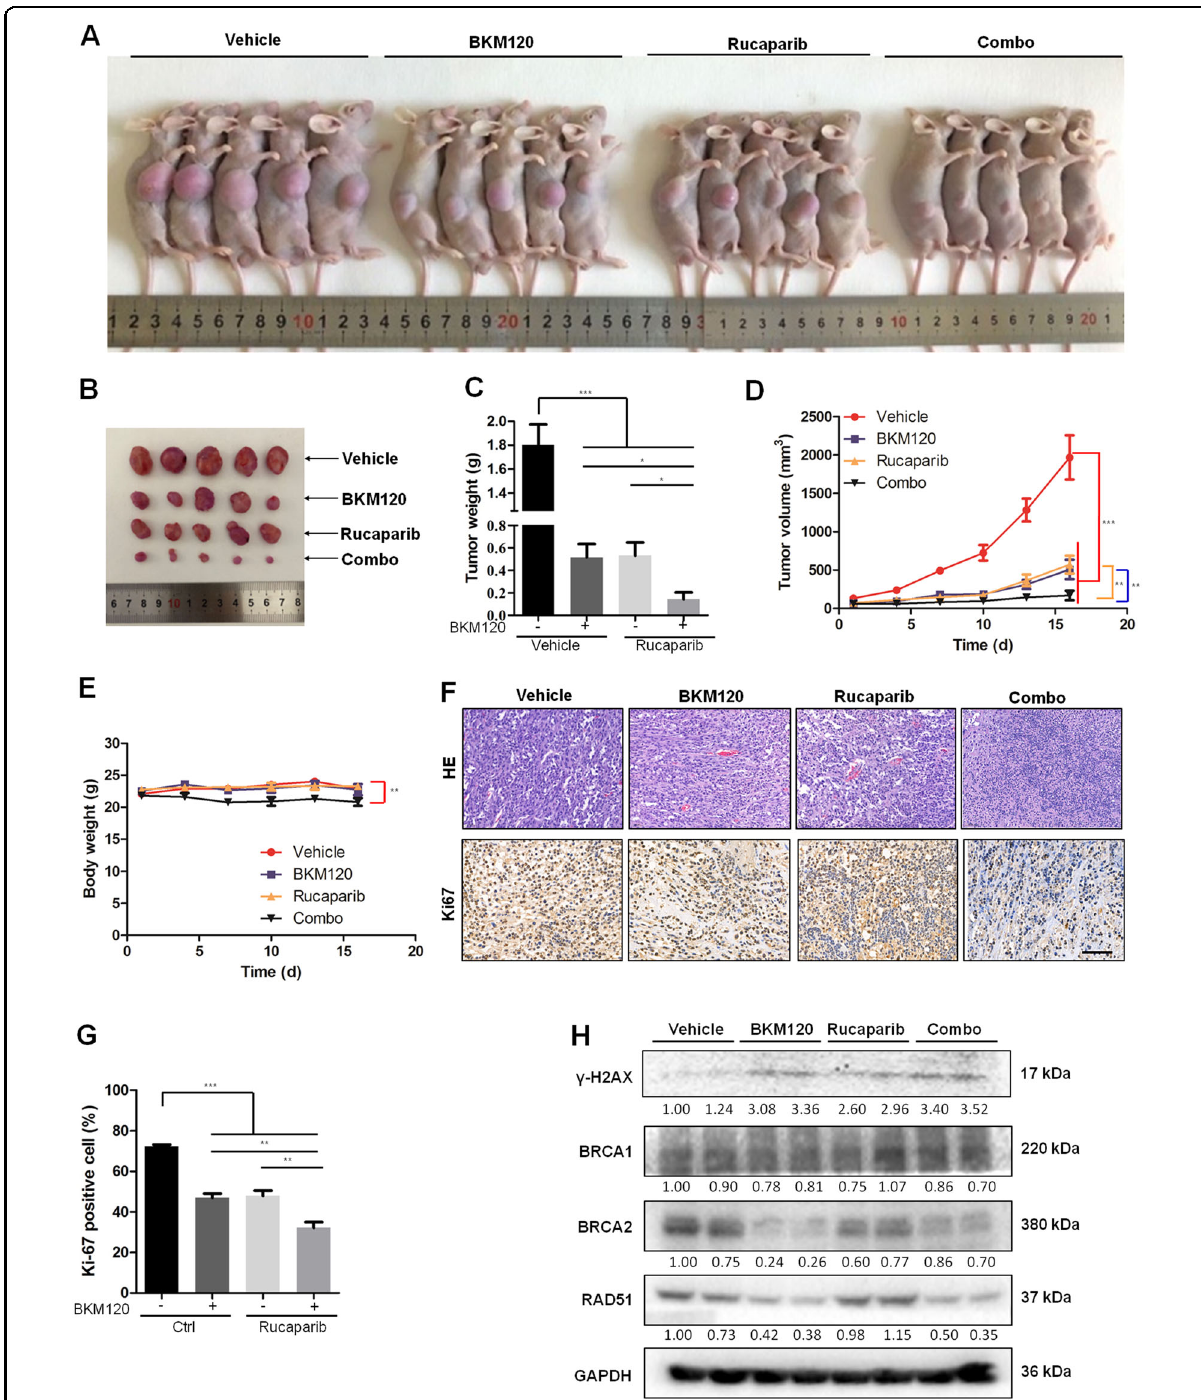
Fig. 5 BKM120/rucaparib combination treatment markedly reduced tumor growth in U87MG nude mouse heterotopic xenograft models. A – H Nude mice with subcutaneous U87MG tumors were treated with vehicle, BKM120 (15 mg/kg), rucaparib (4 mg/kg), or the BKM120/rucaparib combination for 16 days ( n = 7). After sacri fi cing mice, images were taken as shown in ( A ). Then, tumors were taken from mice with the pictures indicated in ( B ). C Measurement of tumor weight. Time-course measurements of tumor volumes ( D ) and body weights ( E ) every 3 days. F H&E and Ki67 immunohistochemistry staining of tumor tissues from U87MG xenograft mice treated with BKM120 and/or rucaparib. Scale bar: 50 μ m. G Statistical quanti fi cation of ( F ) shows U87MG cell proliferation in xenografts with the indicated treatments. H western blotting analysis of BRCA1 and γ -H2AX in harvested tumors. Data are presented as the mean ± SD ( n = 3). * P < 0.05; ** P < 0.01; *** P <